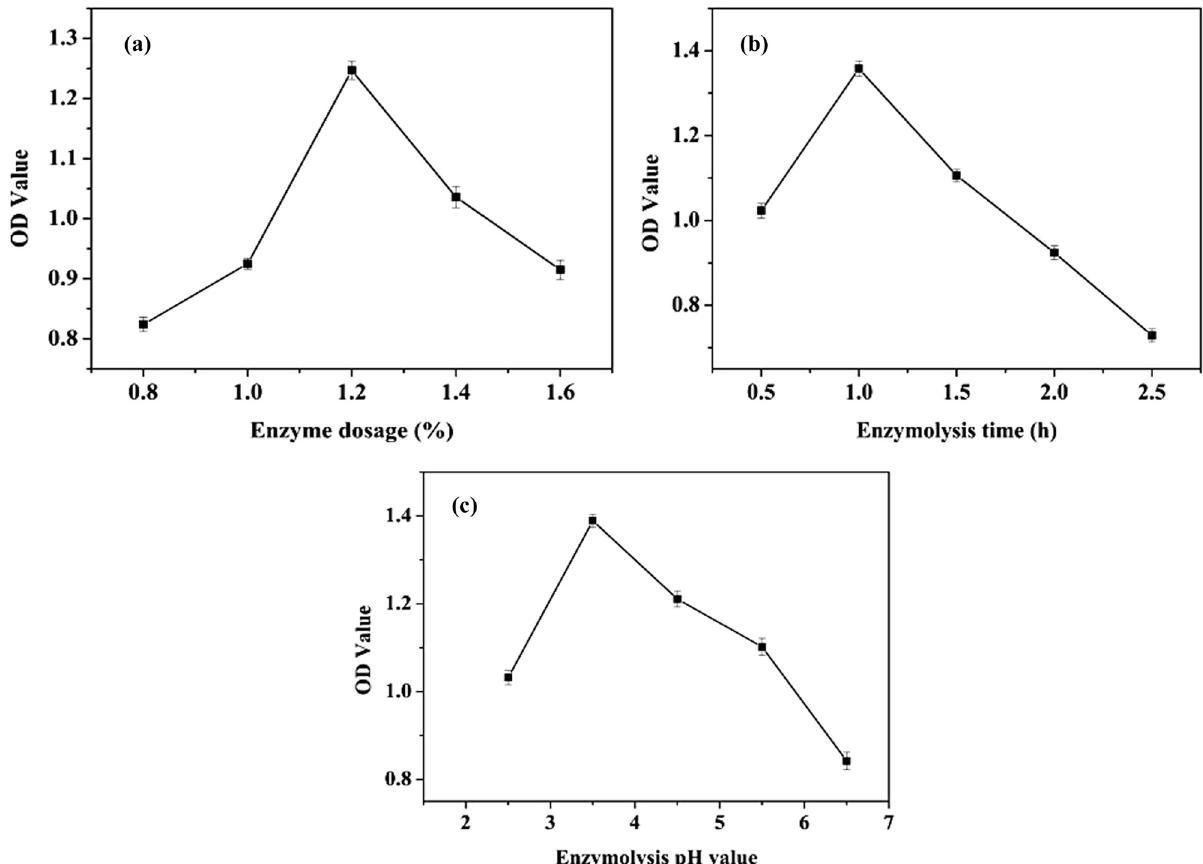
Figure 2: E ff ect of cellulase treatment on the pigment extraction. E ff ects of enzyme concentration ( a ) , enzymolysis time ( b ) , and enzymolysis pH ( c ) on the extraction of red pigment from matured jujube fruits ( n = 3; error bar, a standard deviation of the sample, SD; OD value is the optical density value measured at 280 nm )